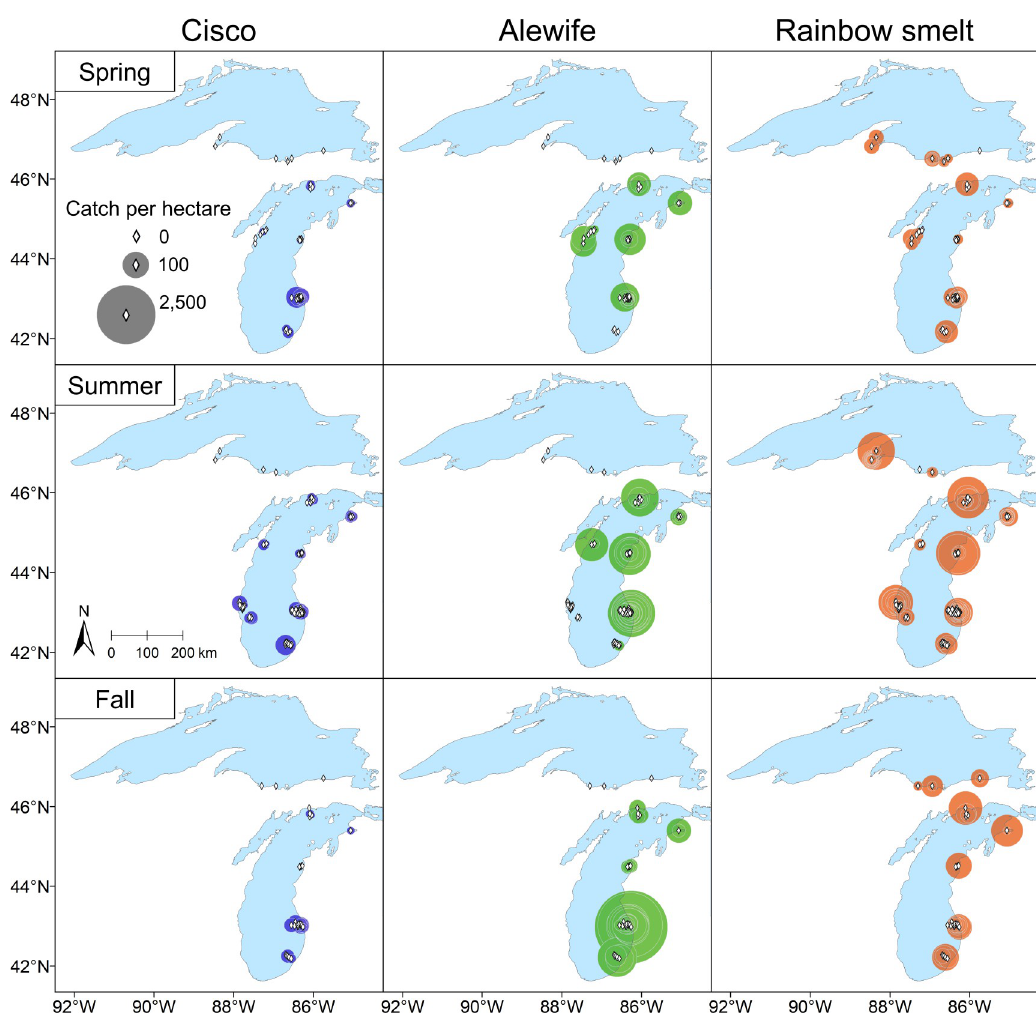
Fig 8. Maps of observed bottom-trawl catch per unit effort (CPUE) for Cisco, Alewife, and Rainbow Smelt in Lake Superior and Lake Michigan, 1959–1962. The CPUE is expressed as catch per hectare of area swept by the trawl. Lake Superior data were collected from four-seam trawls with headrope lengths of 9.4–11.9 m, while Lake Michigan data were collected from two-seam trawls with a headrope length of 15.2 m. Each diamond represents a survey station. Each circle, centered at a diamond, represents the CPUE at that station, and its area is proportional to the square root of CPUE. Each diamond without a circle around it represents a zero CPUE at that station. The maps were generated with geographic information system (GIS) software ArcGIS version 10.8 (http://www.esri.com/software/arcgis/). The GIS layers of observed bottom-trawl CPUE were generated in this study, while the GIS layer of the Great Lakes outline was obtained from the Great Lakes Aquatic Habitat Framework’s [17] public domain spatial database